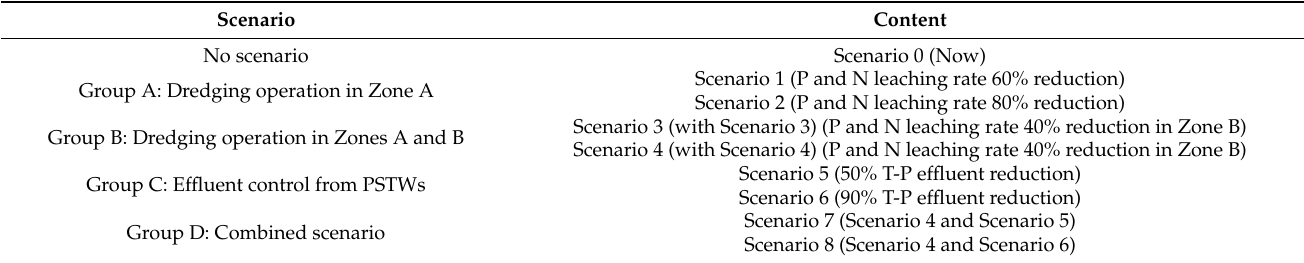
Table 3. Description of the applied scenario in this